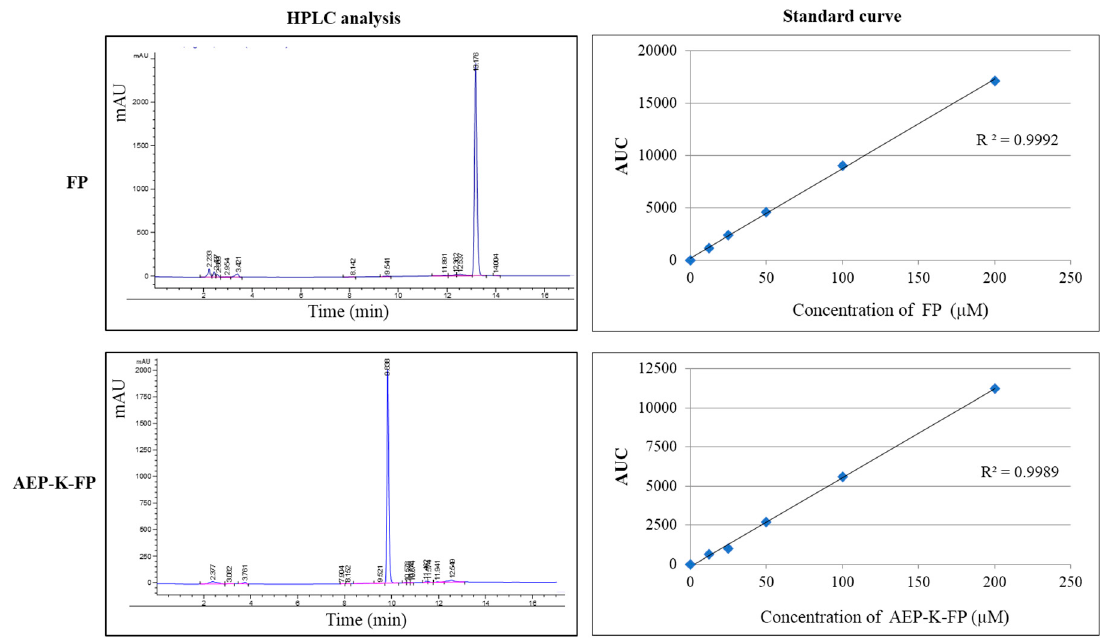
Figure 6. The high performance liquid chromatography (HPLC) analysis and corresponding standard curve of FP and AEP-K-FP.